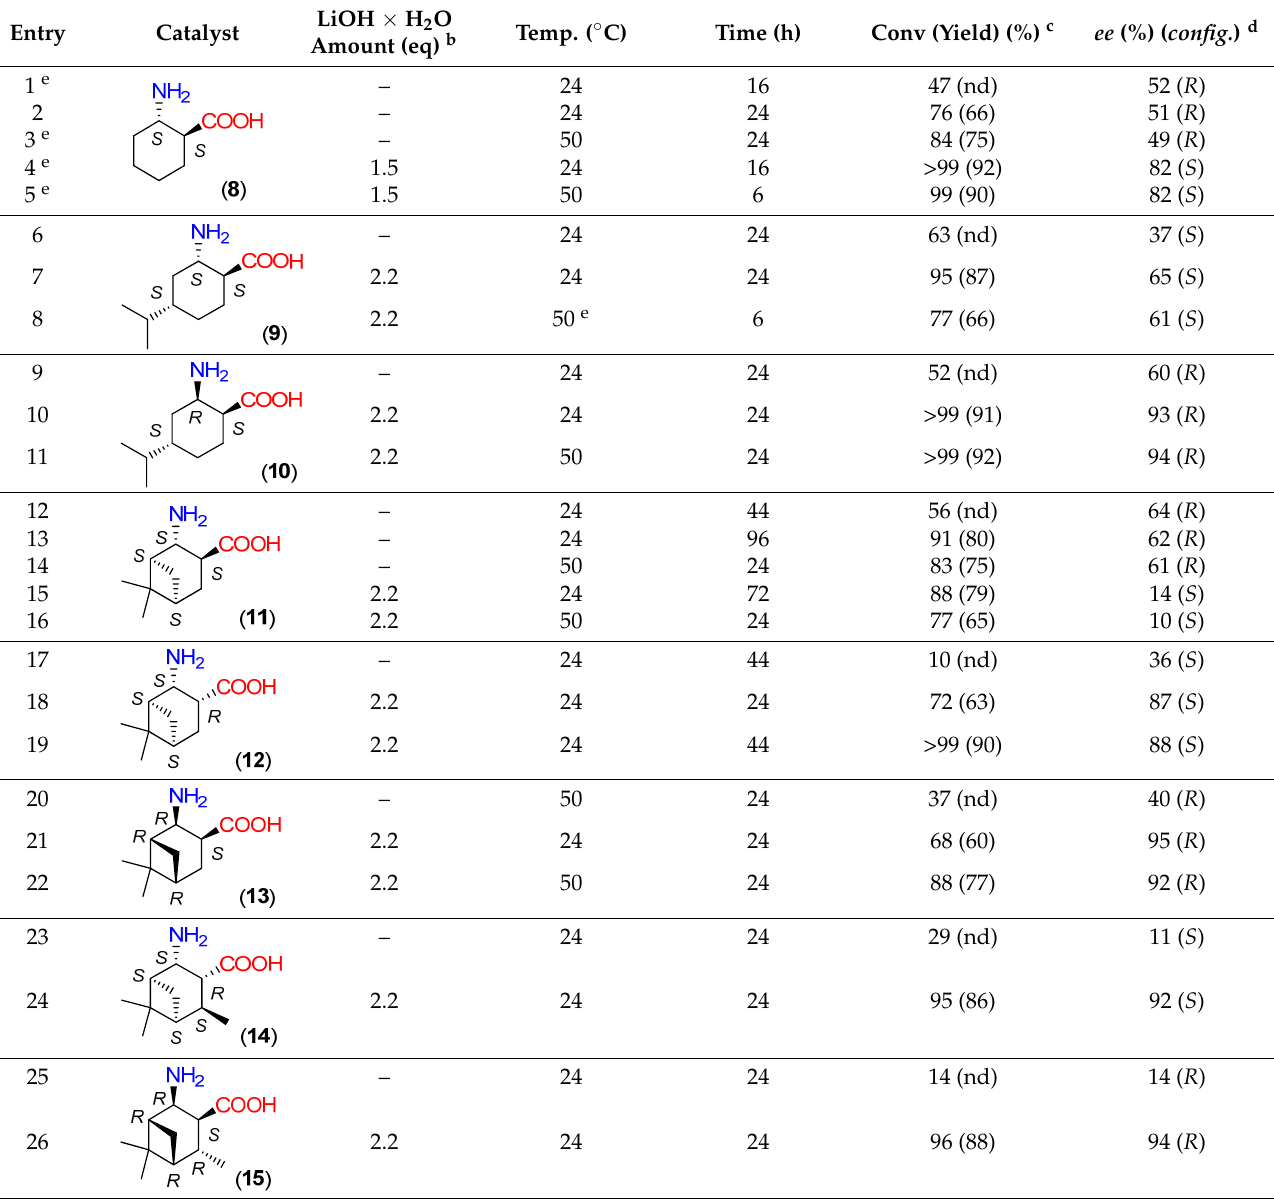
Table 3. Asymmetric Michael addition of 2 to 1a catalysed by β‐ amino acids 8 – 15 having a cyclo ‐ hexane backbone a . Catalyst Entry